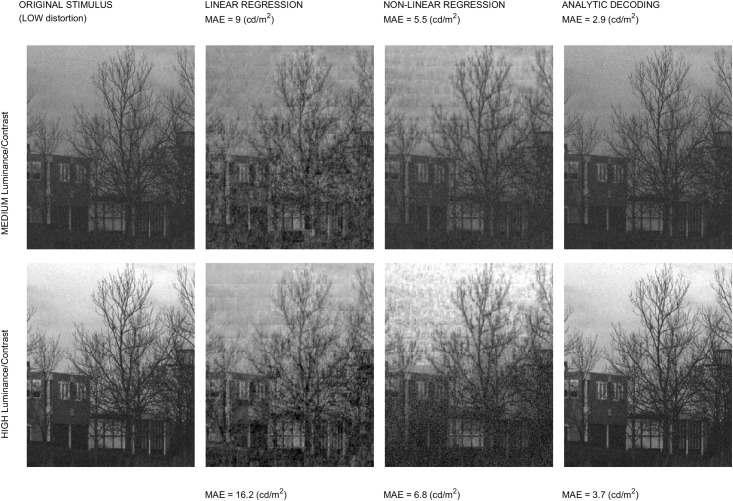
Reconstructions in the low-distortion regime.These six reconstructions correspond to the highlighted dots in the surfaces at the left plot of Fig 13. The analytic decoding clearly overperforms the learning algorithms even in the case that the image has the illumination conditions used in the training (medium luminance/contrast) and the decoders are those trained for the considered distortion.